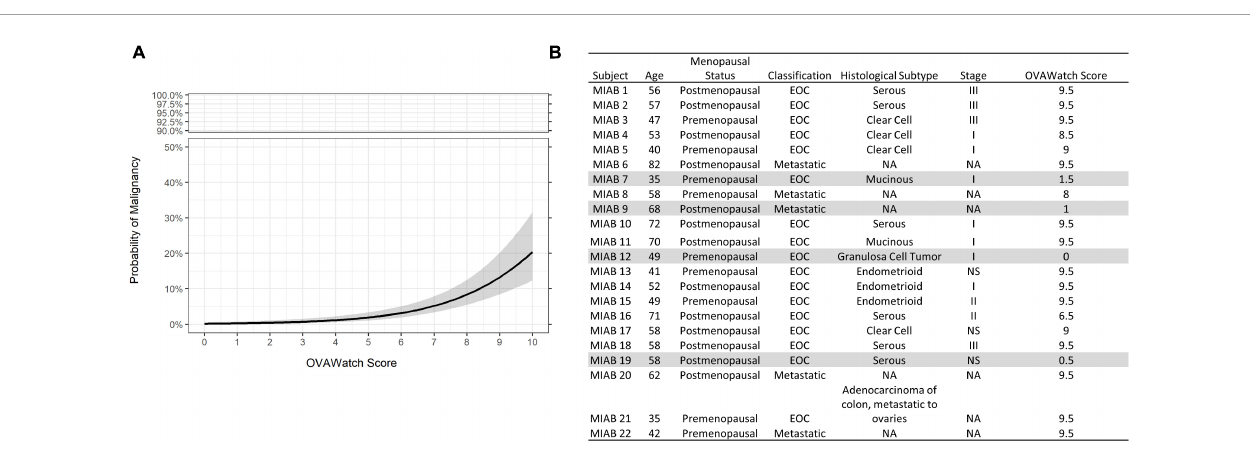
FIGURE4 (A) Probability of malignancy as a function of OVAWatch in the multivariate index assay benign (MIAB) dataset. (B) Table of characteristics of all patients in the MIAB dataset who were histologically malignant. Shaded rows are false negative